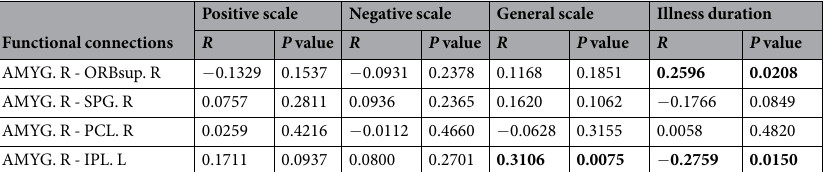
Table 4. Associations between SampEn of functional connections and clinical variables. R is the partial correlation coefficient. P values less than 0.05 are marked in bold. AMYG, amygdala; ORBsup, superior orbital frontal gyrus; SPG, superior parietal gyrus; PCL, paracentral lobule; IPL, inferior parietal gyrus; L, left; R,